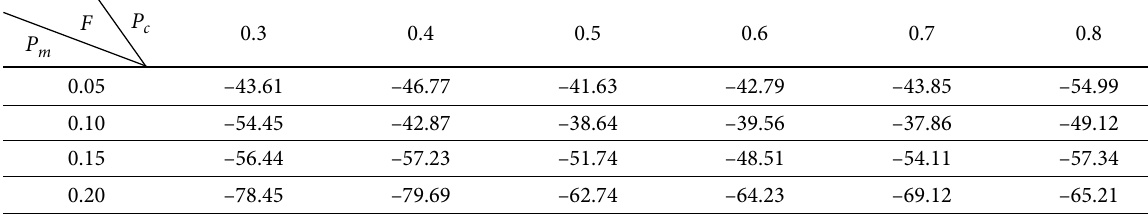
Table 2. Coach timetable of Dalian airport ( T = 3, T ′ = 2)